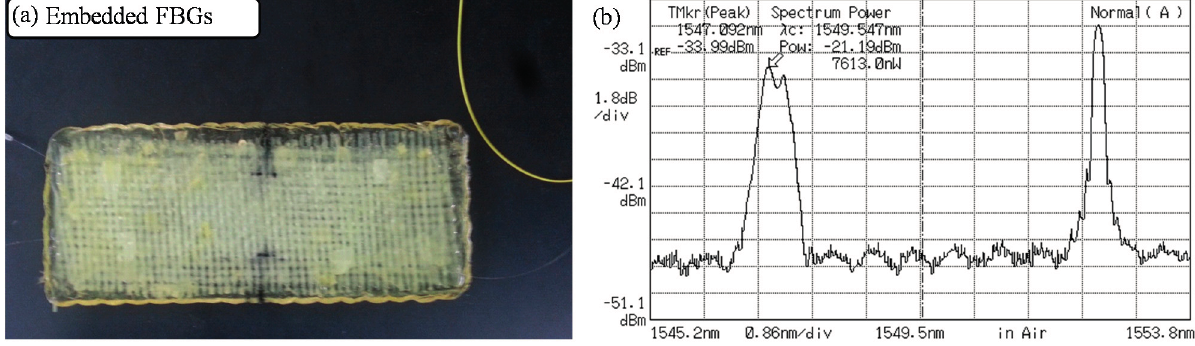
Figure 8. Distortion in Bragg spectrum (( a ) Cured composite block, ( b ) FBG’s Bragg spectrum (left: distorted